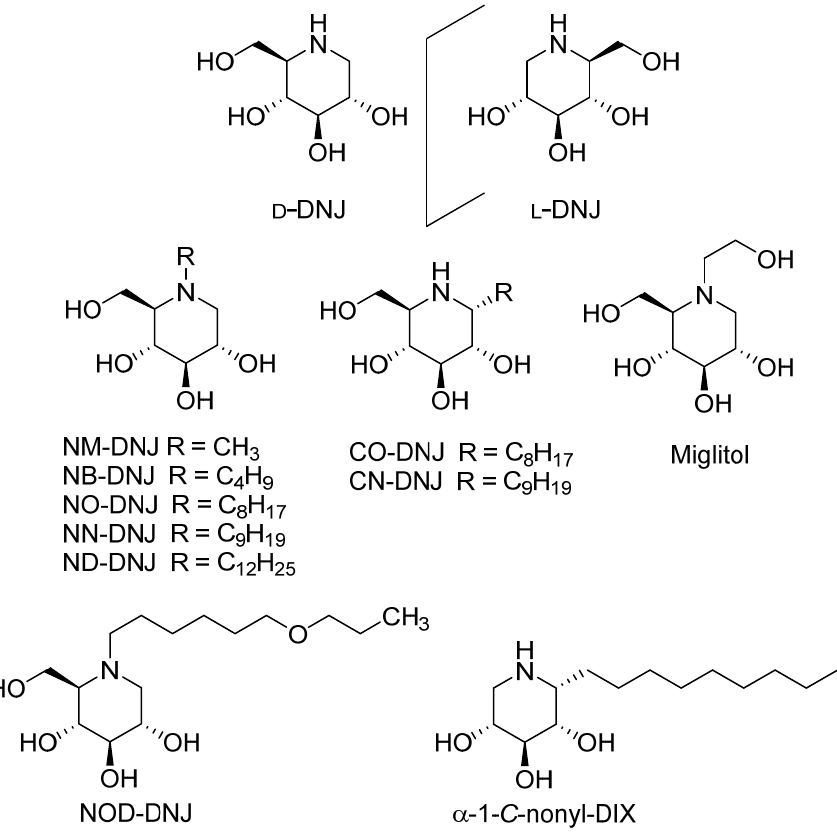
Figure 1. Structures of N -alkyl and C -alkyl derivatives of DNJ: D -DNJ and L -DNJ, N -methyl-DNJ (NM-DNJ), N -butyl-DNJ (NB-DNJ), N -octyl-DNJ (NO-DNJ), N -nonyl-DNJ (NN-DNJ), N -dodecyl- DNJ (ND-DNJ), C -octyl-DNJ (CO-DNJ) and C -nonyl-DNJ (CN-DNJ), N -(7-oxadecyl)-DNJ (NOD- DNJ), N -hydroxyethyl-DNJ (miglitol) and α -1- C -alkyl- D -xylitol ( α -1- C -nonyl-DIX).